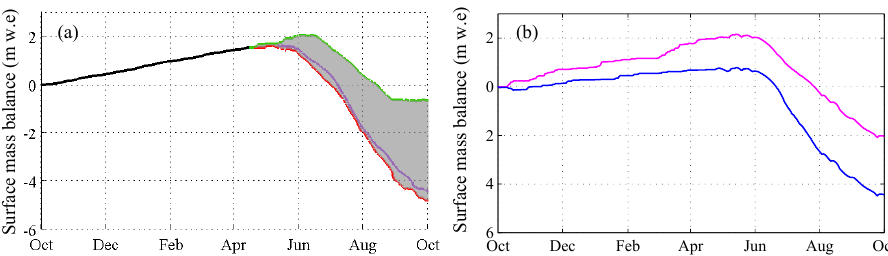
Figure 6. (a) Surface mass balance at stake 10, (2760ma . s . l . ) over one hydrological year, using averaged winter conditions and all summer conditions for the period 1995–2015. Red line represents simulation with 2003 summer conditions and the green line represents 1995 summer conditions. All the other years are included in the grey area. (b) Surface mass balance at stake 10, over one hydrological year, using averaged summer conditions (over 1996–2015), 2000–2001 winter conditions (pink) and 2008–2009 winter conditions (blue), representing the two extreme